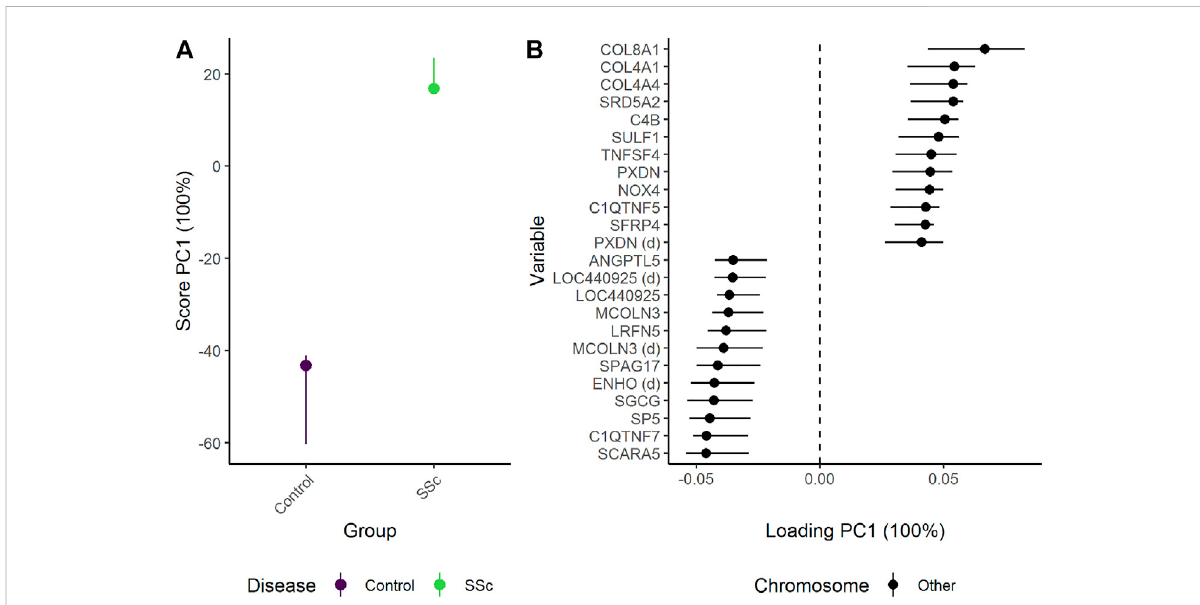
FIGURE 10 The difference in skin biopsy transciptome between healthy controls and patients with systemic sclerosis (SSc) as (A) scores and (B) loadings. The effects of age and gender have been adjusted for (Figure 11). The expression of genes with high loading is increasing when the scores increase and vice versa . Only the 12 genes with highest and lowest loadings, separated by the vertical dotted line, are shown due to the large number of assessed